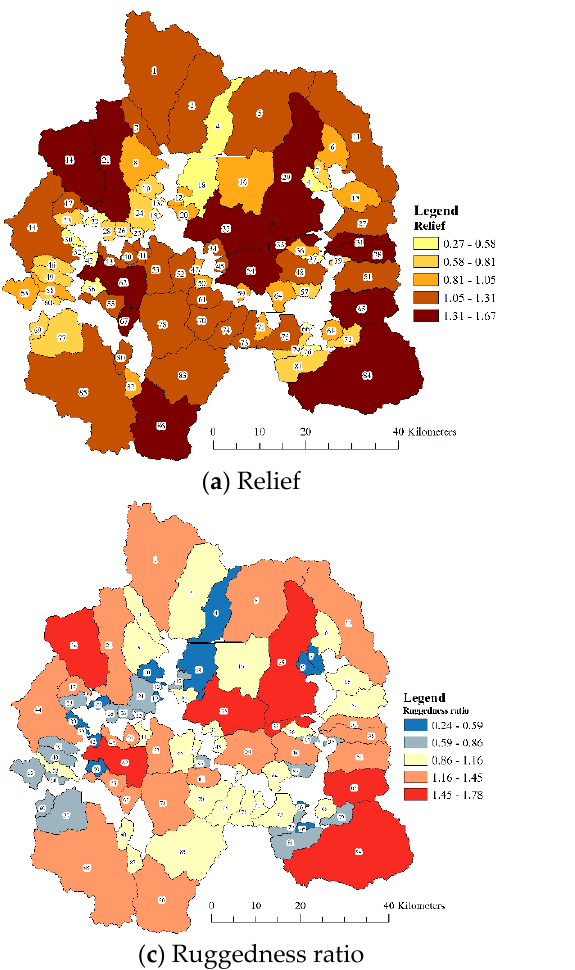
Figure 7. Relief features parameters ( a ) Relief; ( b ) Relief ratio; ( c ) Ruggedness ratio; ( d ) Relative relief ratio.